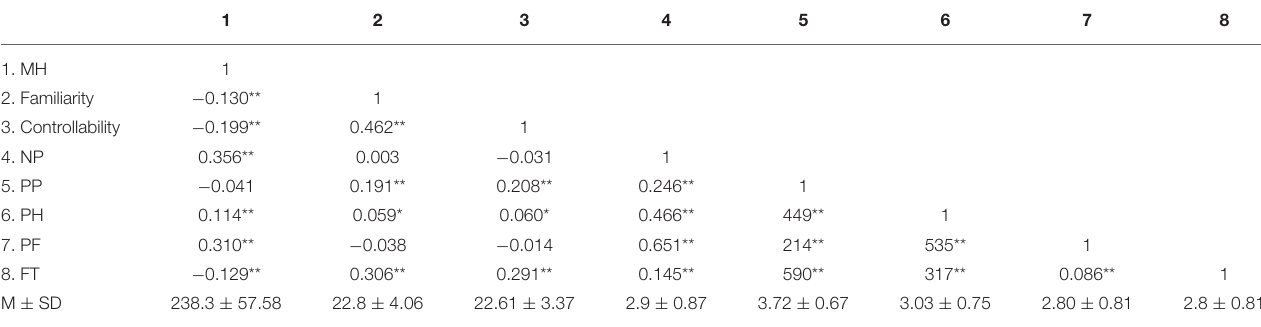
TABLE 3 | Correlation analysis between risk perception and college students’ mental health and time insight during the COVID-19 epidemic. 1 2